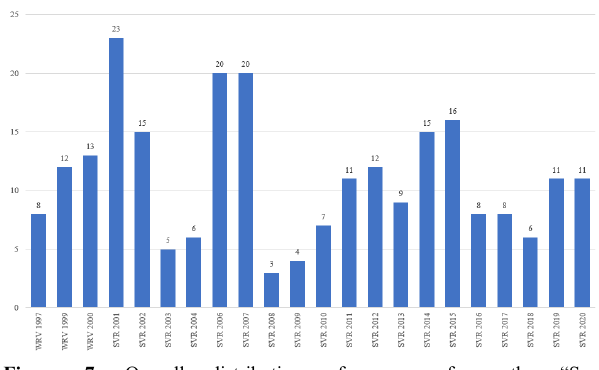
Figure 7. Overall distribution of papers from the “Sys- tems/Frameworks/Toolkits” topic. in the work of Zuffo et al.